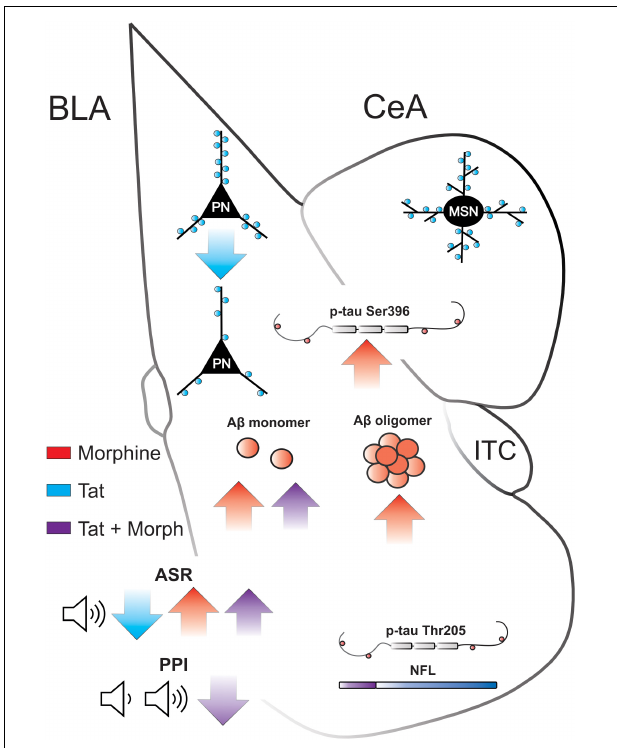
FIGURE 7 | Summary of Tat and morphine-induced amygdalar deficits. BLA, basolateral amygdala; CeA, central nucleus of the amygdala; ITC, intercalated cells; PN, pyramidal neuron; MSN, medium spiny neuron; A β , amyloid- β ; p-tau, phosphorylated tau; NFL neurofilament light; ASR, acoustic startle response; PPI, prepulse inhibition. ↑ or ↓ indicate significant increase or decrease, respectively, by Tat (red), morphine (blue), or the interaction of Tat and morphine